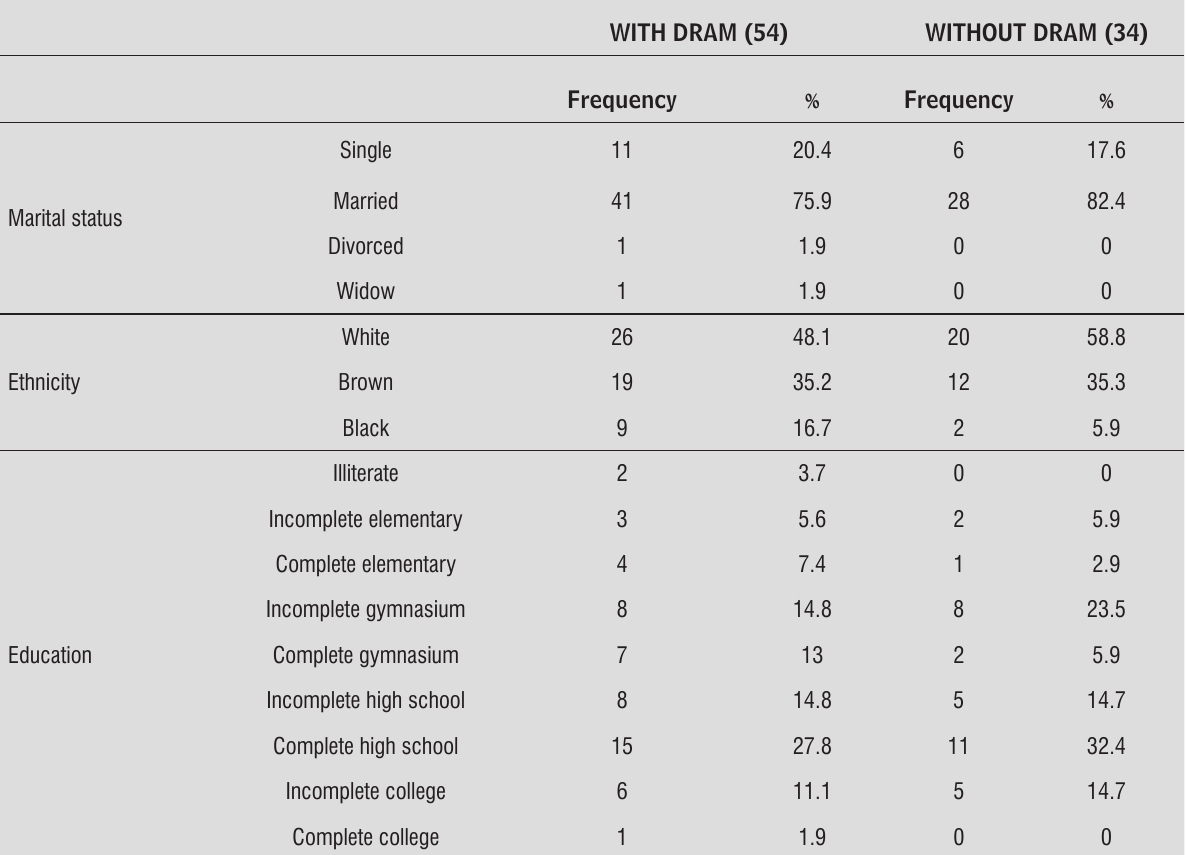
Table 1 - Socio Demographic data of the participants, according to the presence or absence of DRAM, 2012